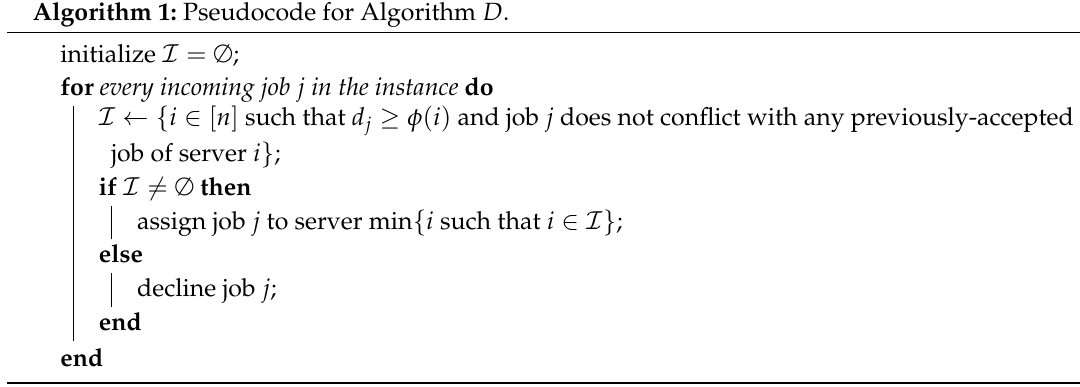
Algorithm 1: Pseudocode for Algorithm D .